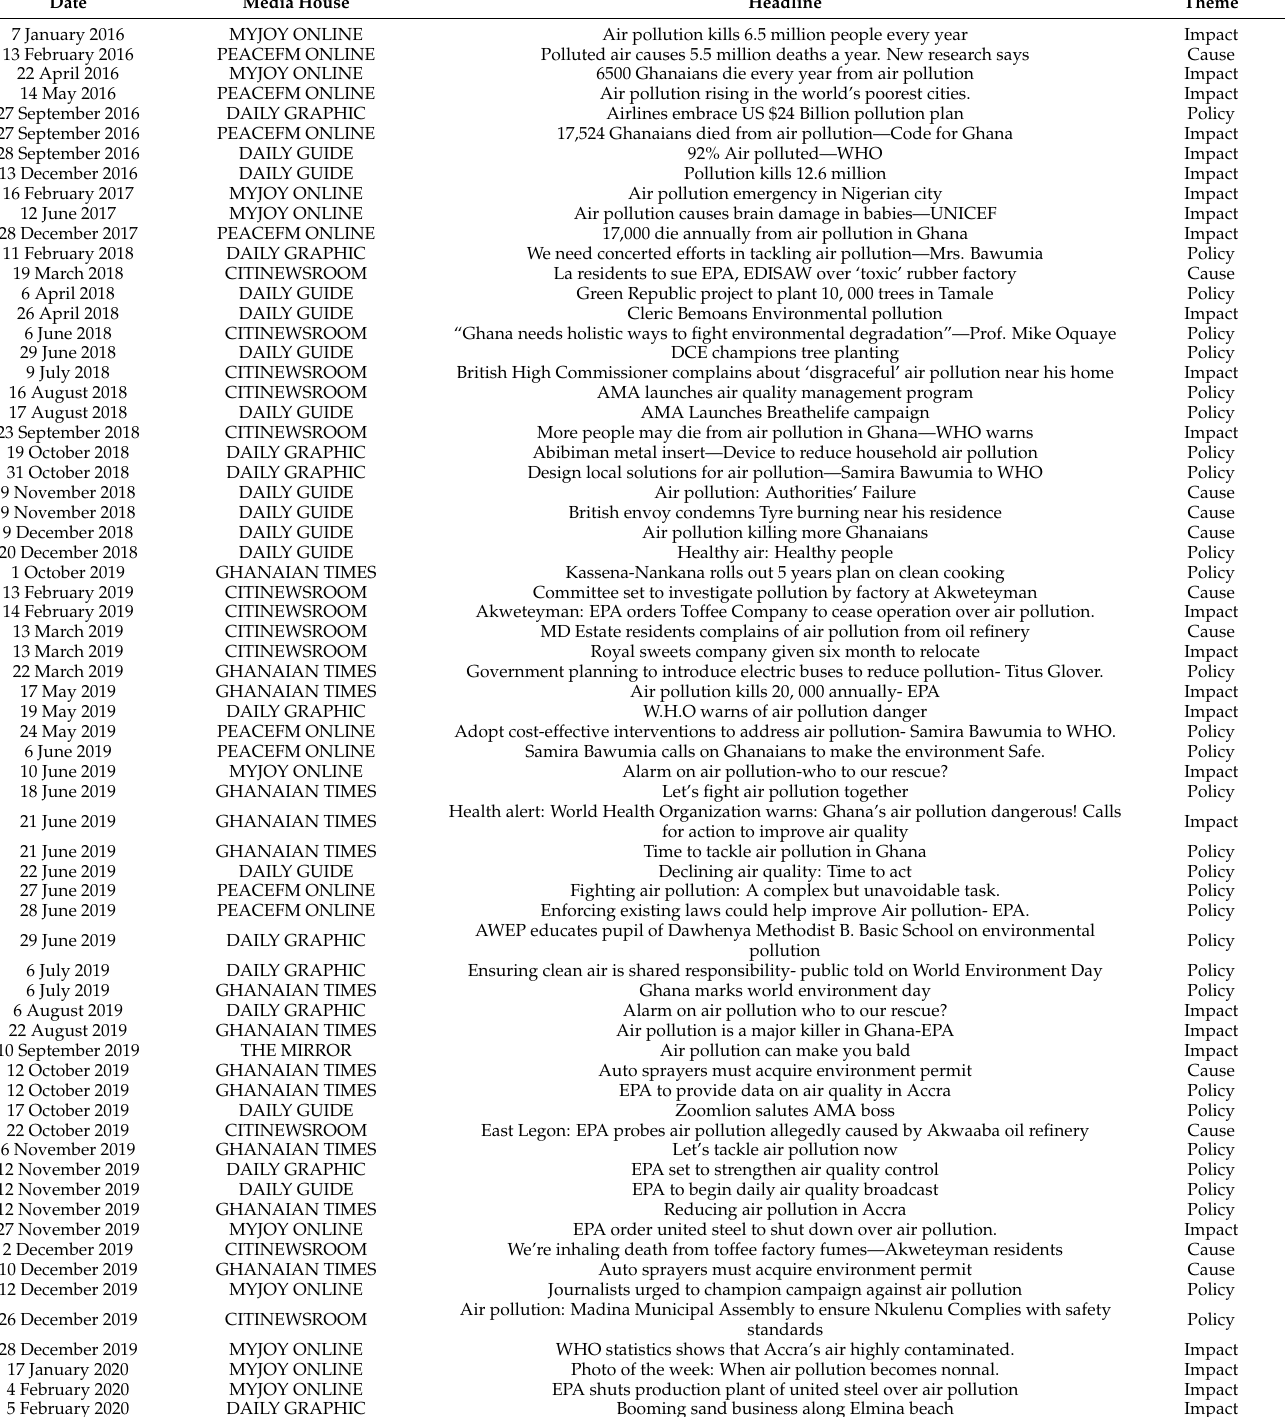
Table A1. Summary of headlines on air pollution by media houses in Ghana for